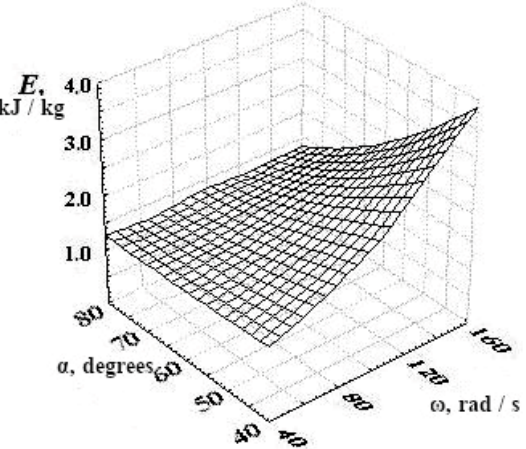
Figure 8. Dependence of energy consumption E on the angle, complementing up to 90° the angle of finger installation relative to radius α o and rotation frequency of the rotary finger working body ω at δ = const.